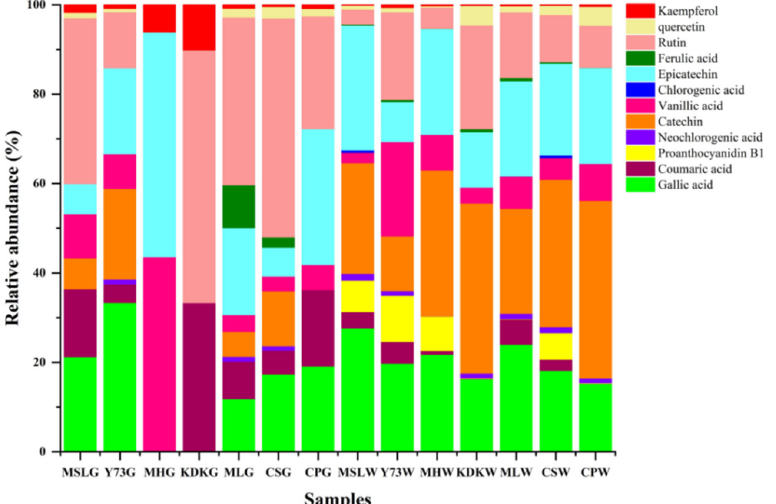
Figure 4. The relative abundance of 12 polyphenols in 7 grape cultivars and corresponding wines. Samples’ full names, as follows: MSL (Marselan), Y73 (Yan 73), MH (Muscat Hamburg), KDK (Kadarka), ML (Merlot), CS (Cabernet Sauvignon) and CP (Crimpose). Furthermore, G represents “grape” and W represents “wine”.